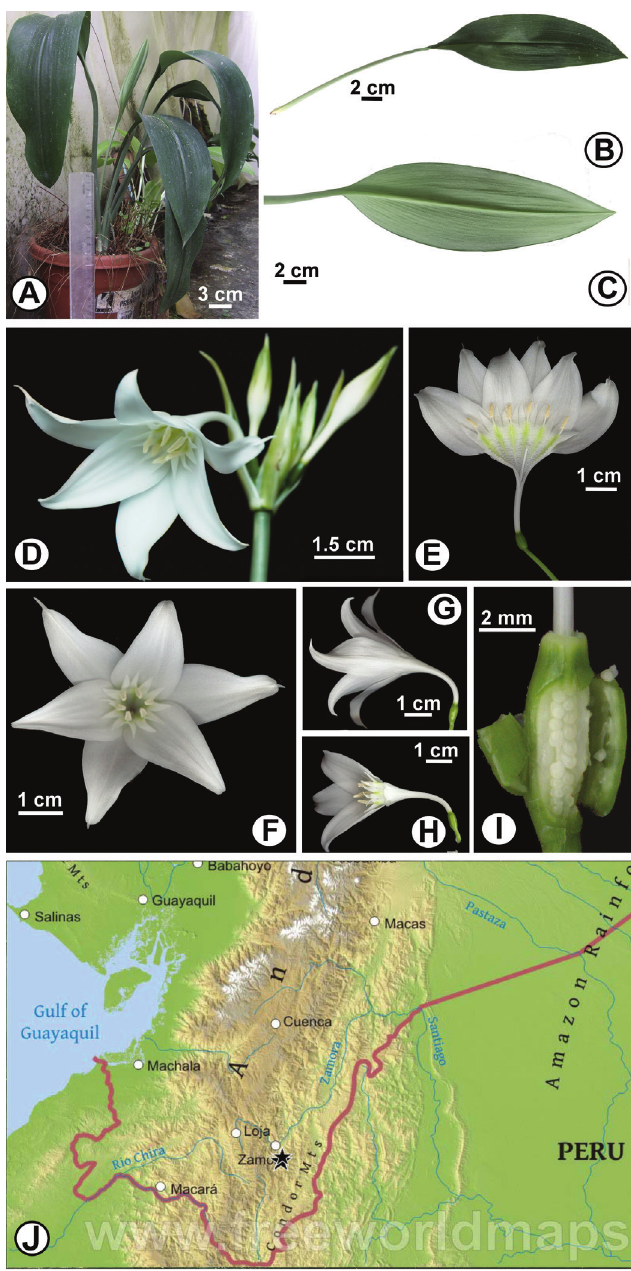
Figure 3. Eucharis ruthiana . A Plant in cultivation B–C Leaves B Adaxial view C Abaxial view D–H Flowers D Upper portion of inflorescence showing flower habit E Flower cut and spread to show staminal corona F Dorsal-ventral view of limb showing the spread of the androecium G Lateral view H Lateral view with three tepals removed to show androecium I Ovary dissected to show numerous, superposed, globose ovules J Distribution of E. ruthiana in Ecuador (black stars). Map courtesy of